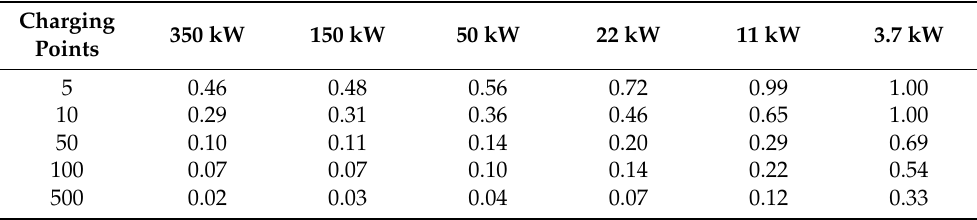
Table A4. Demand factors for the area type “Urban Region: Small-town Area, Village Area” and six charging powers.